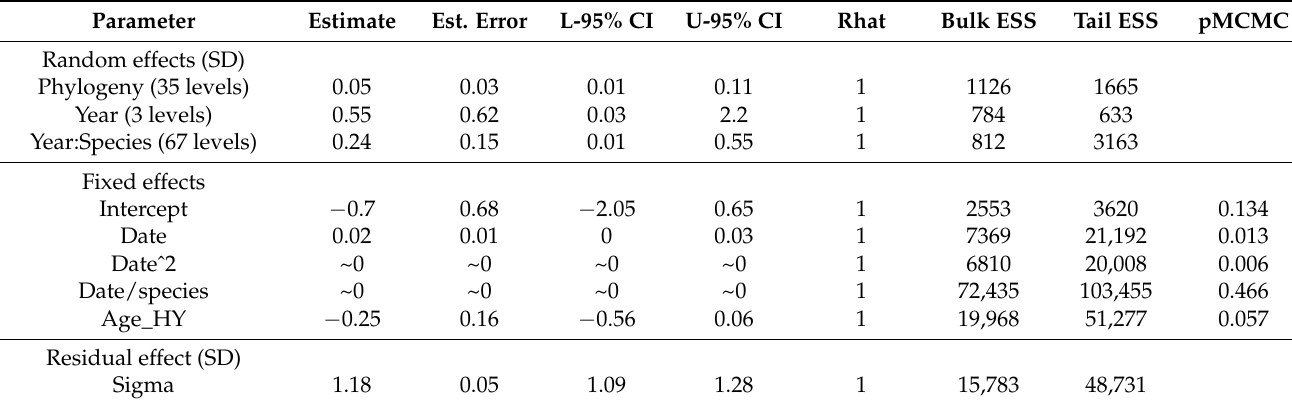
Table 5. Bayesian multivariate multilevel model on the predictors of haemosporidian infection intensity in a local avian community in Drienovec, Slovakia, during 2017, 2018 and 2019.